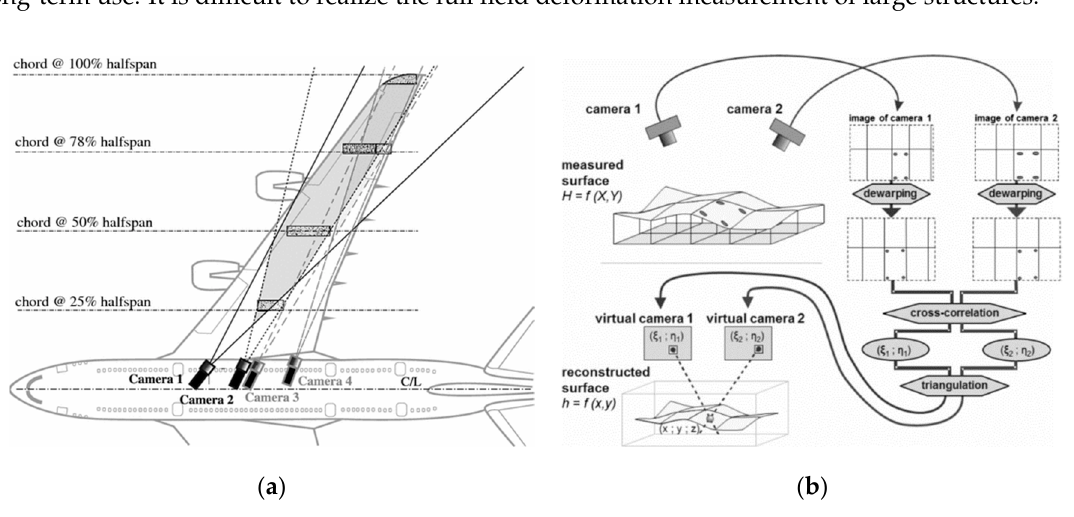
Figure 13. ( a )Application of Image Pattern Correlation Technique (IPCT) cameras sets placed in aircraft for wing deformation measurements; ( b ) IPCT processing flow [50].